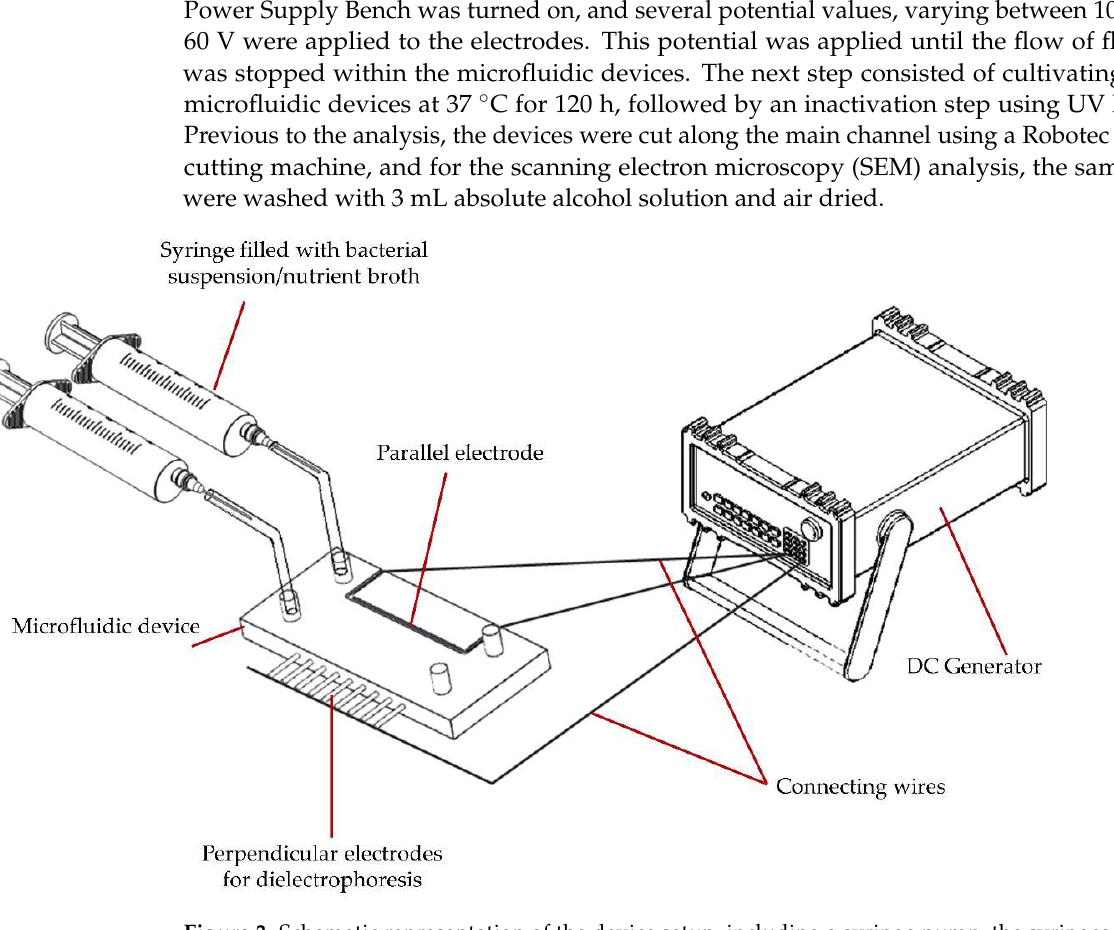
Figure 3. Schematic representation of the device setup, including a syringe pump, the syringes filled with bacterial suspension and nutrient broth, the microfluidic device with perpendicular and parallel electrodes, and the DC generator.